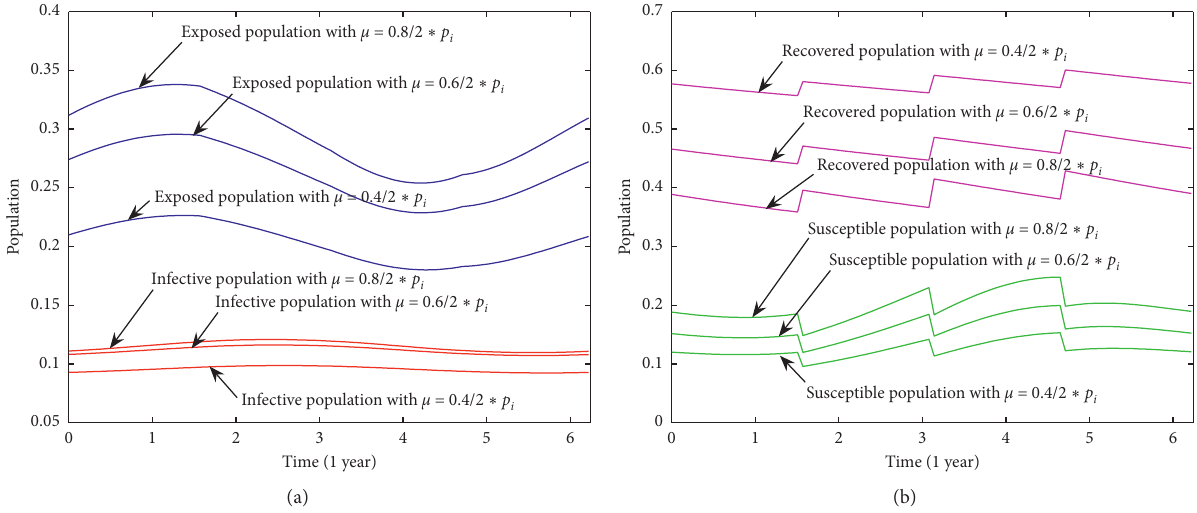
Figure 5: Exposed population, infective population, recovered population, and susceptible population with μ � 0 . 8/2 π , μ � 0 . 6/2 π , and μ � 0 . 4/2 π .